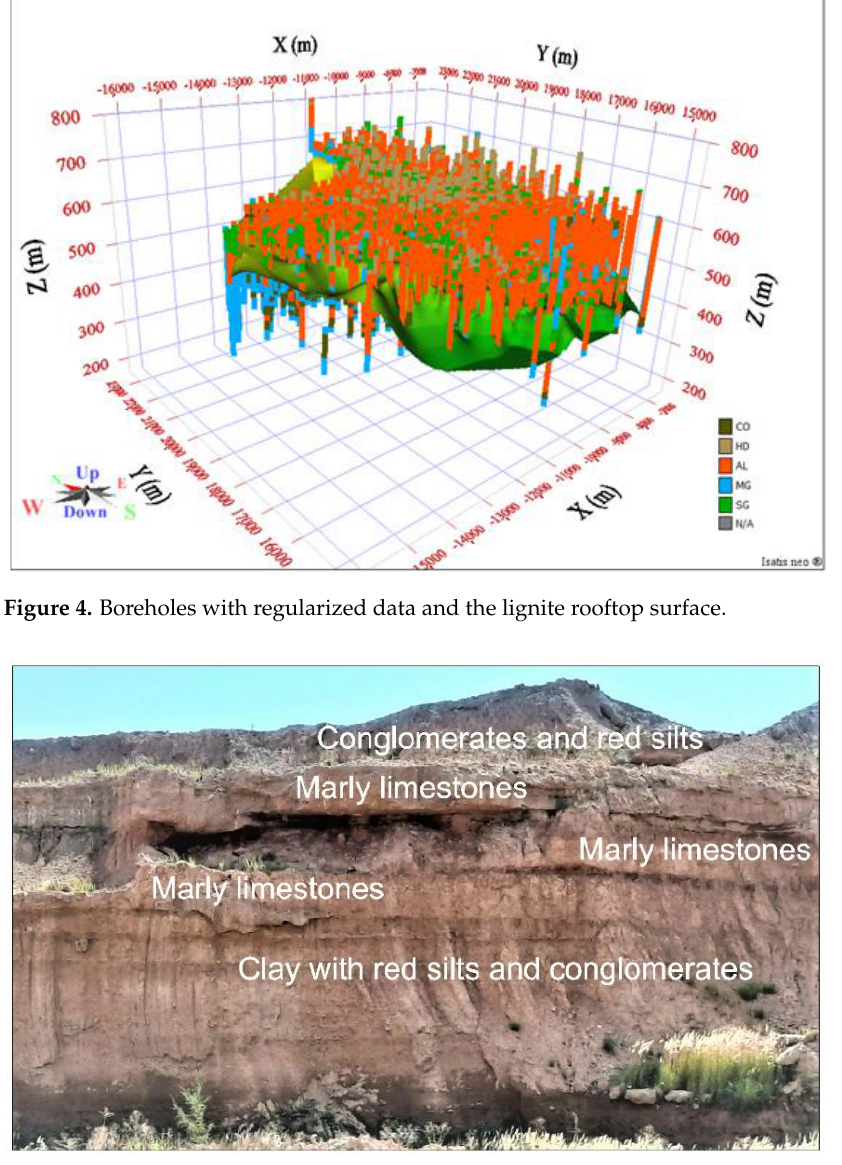
Figure 5. Interpretation of geological formations (the location of the photo is shown in Figure 3). The overburden area can then be defined between the earth’s surface and the geo- logical rooftop of the lignite orebody, as seen in Figure 6. This domain is divided into 58,609 horizontal parallelepiped blocks sizing 100 m × 100 m × 10 m each. For functional- ity reasons, the drills’ data were discretized in the 3D overburden grid, and a lithofacies value was assigned to each block crossed by a borehole. This operation was accomplished in two steps. First, the boreholes were cut into regular samples of 10 m, a size that corresponds to the depth of the basic grid cell. Then, after compositing, these regularized samples were migrated to the closest grid block so a single lithotype value would be assigned to the blocks crossed by a well. These blocks will, this way, become the conditioning data in the lithofacies simulation